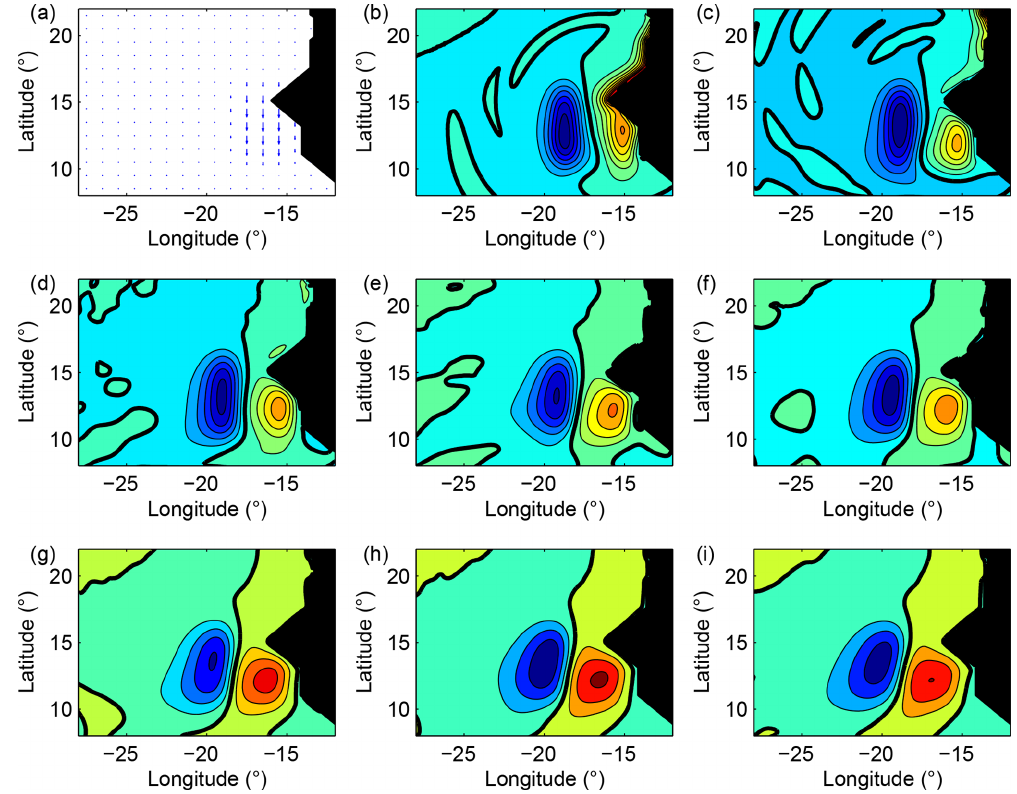
Figure 4. Response of the ocean to an anomalous wind stress applied for 5d (a) and corresponding evolution of the active layer thickness for every 5d from the close of the wind stress anomaly up to 35d after ( b – i ). A Rossby wave is generated and a Kelvin wave quickly propagates along the coast. The Rossby wave propagates westward and its amplitude is divided by 2 between ( a ) and ( i ). The 0m isoline is indicated in bold; the isoline interval is 0.5m (blue: